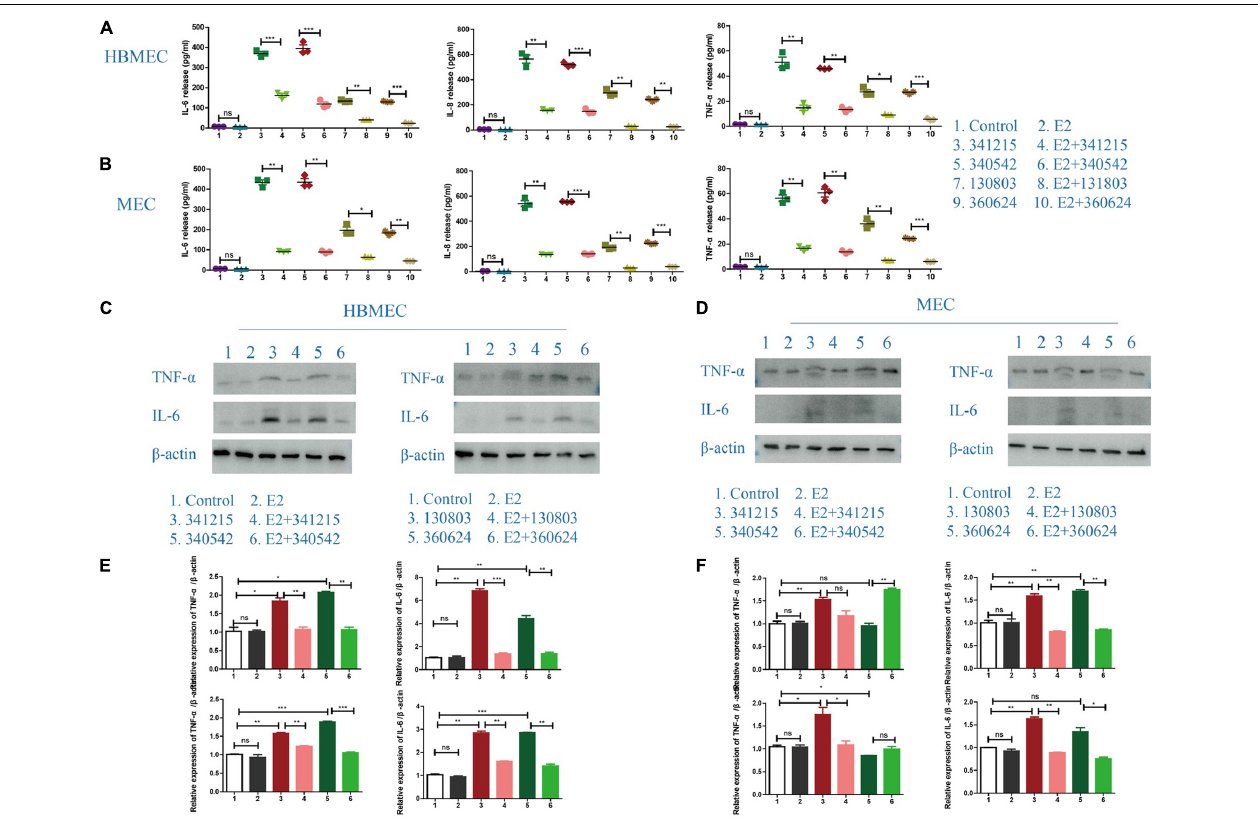
FIGURE 2 | Inflammatory cytokines release in Neisseria meningitidis -infected cells after E2 treatment. (A,B) HBMECs (A) and MECs (B) were treated with N. meningitidis infection and N. meningitidis infection after E2 pretreatment. Cells without N. meningitidis infection and the cells stimulated by E2 only were used as controls. ELISA assays were used to detect the expression of inflammatory factors IL-6, IL-8, and TNF- α in the culture supernatant. (C–F) HBMECs (C) and MECs (D) were treated as above. Western blotting was used to detect the levels of TNF- α and IL-6, with β -actin used as a loading control. The levels of the above molecules in both cells was analyzed by Image-J software, and the gray analysis value was analyzed statistically using Graph-pad Prism software. NS (not significant) is P > 0.05, * P < 0.05, ** P < 0.01, *** P <